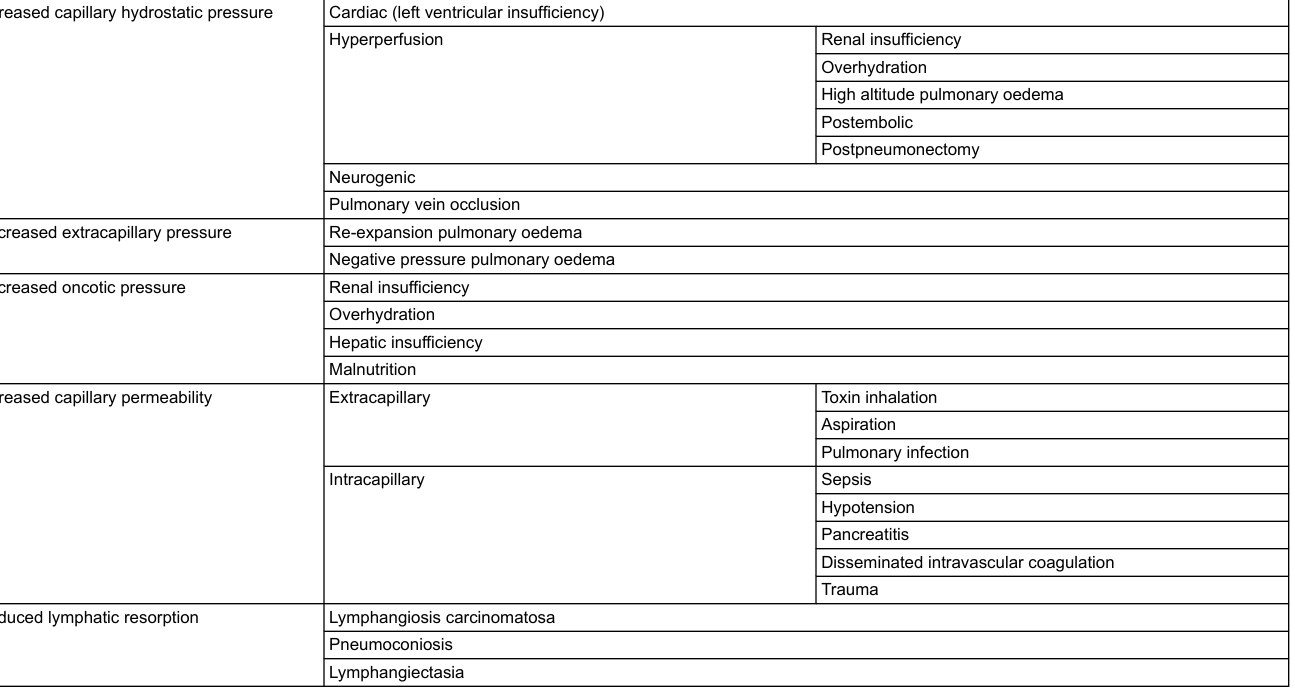
Table 1: Aetiology of lung oedema